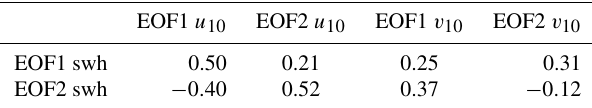
Table 1. Correlation matrix between the EOFs of u 10 /v 10 and swh filtered anomalies at lag